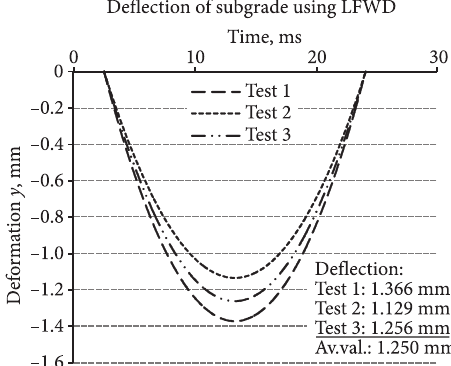
fig. 4. Record of LFWD